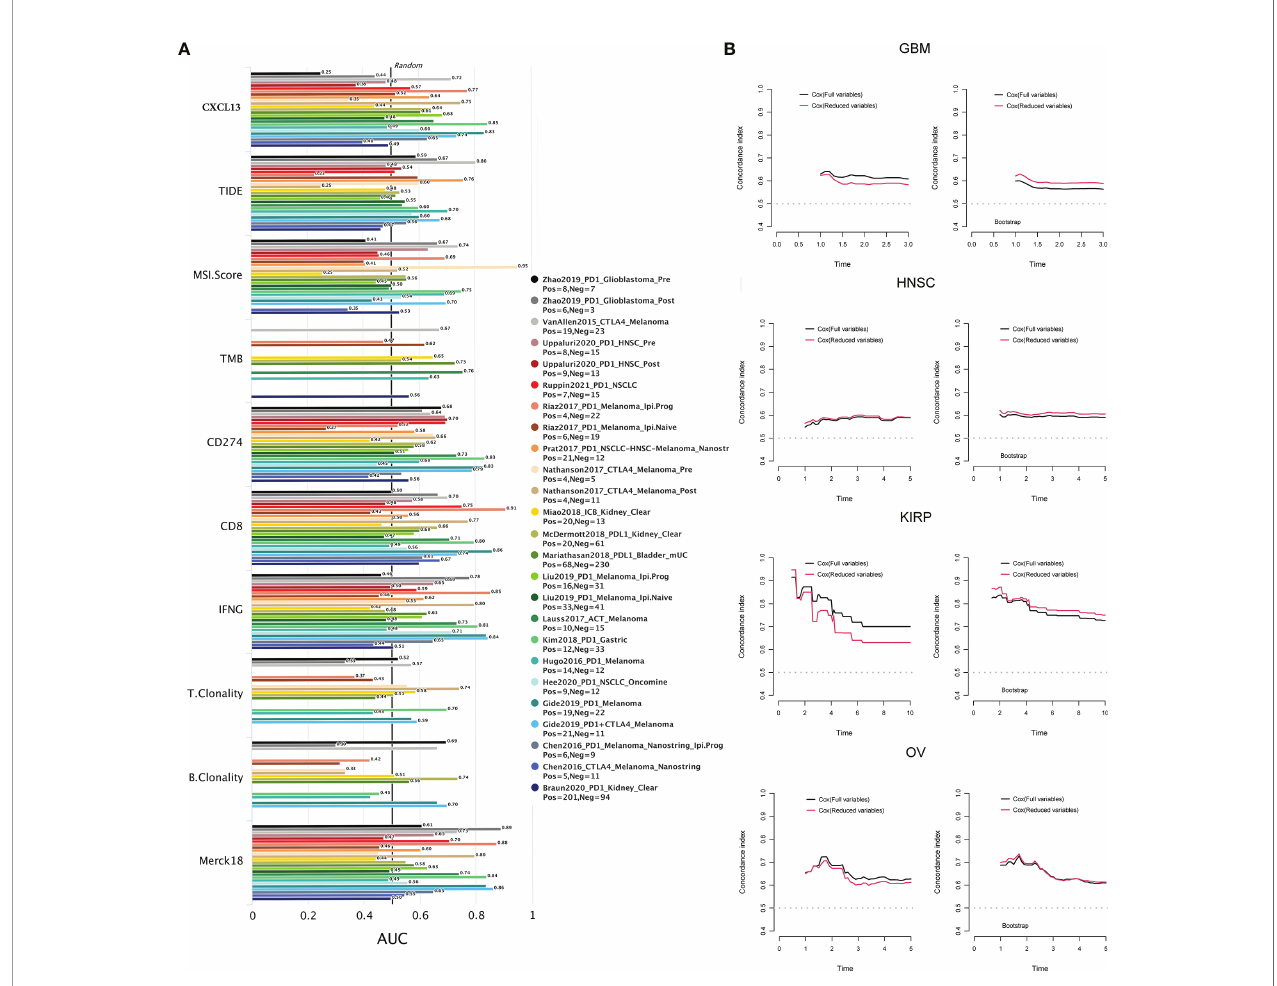
FIGURE 10 | (A) The correlation between CXCL13 and the immunotherapeutic response. (B) The c index and the results of the cross-validation by bootstrap re- sampling method of the full model and reduced model in GBM, HNSC, KIRP and